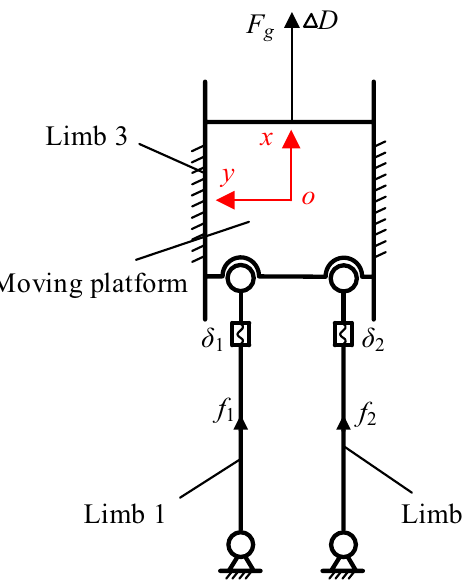
Figure 1 The 2SS P passive overconstrained parallel +